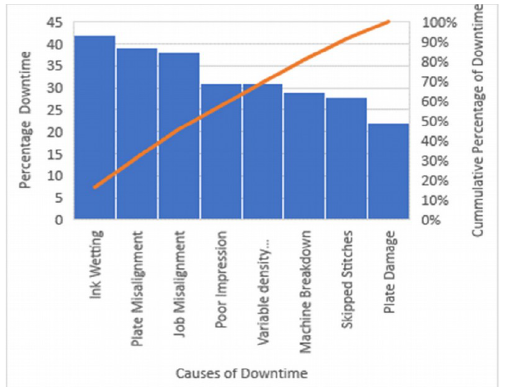
Figure 4. Pareto Chart of the Down Time of AB Production